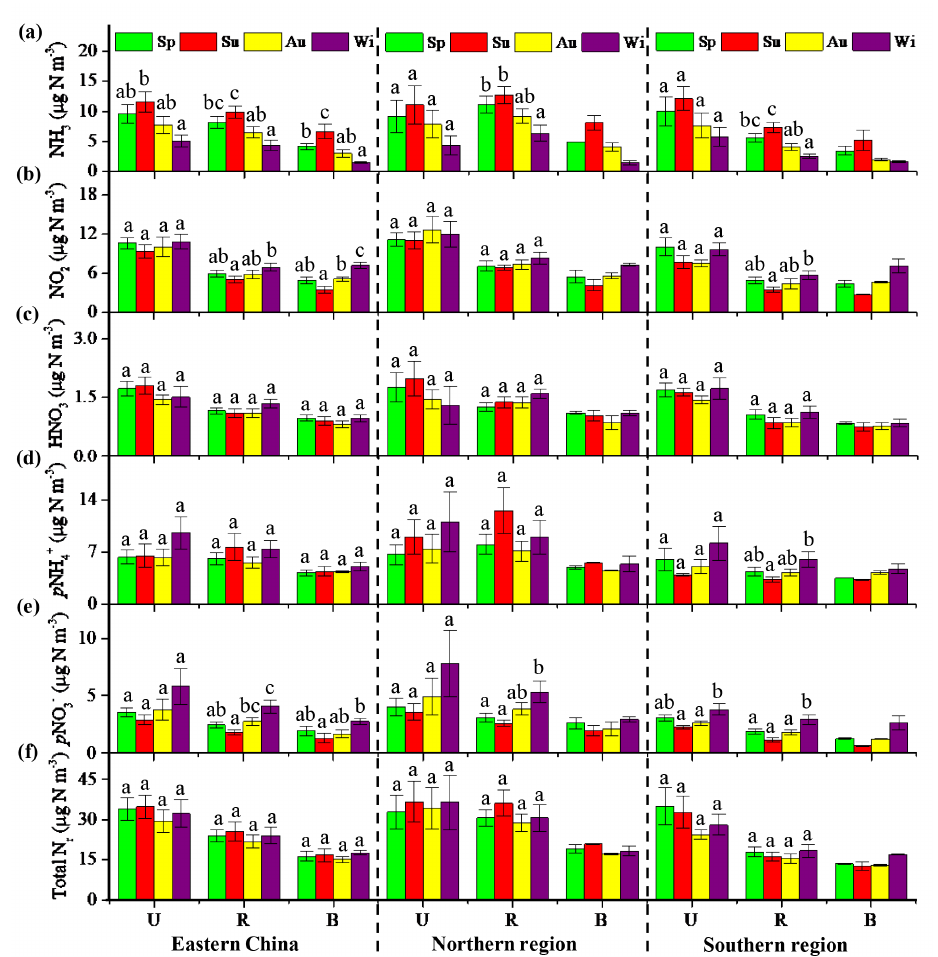
Figure 3. Seasonal mean concentrations averaged over 2011–2015 of (a) NH 3 , (b) NO 2 , (c) HNO 3 , (d) p NH + i.e. the sum of all measured N r in air, at different land use types in eastern China and its northern and southern regions. Sp, Su, Au, and Wi represent spring, summer, autumn, and winter respectively. U, R, and B denote urban, rural, and background sites respectively. The number of sites for each land use type in each region can be found in Table 1. The error bars are the standard errors of means, and values without same letters on the bars denote significant differences between the seasons ( p